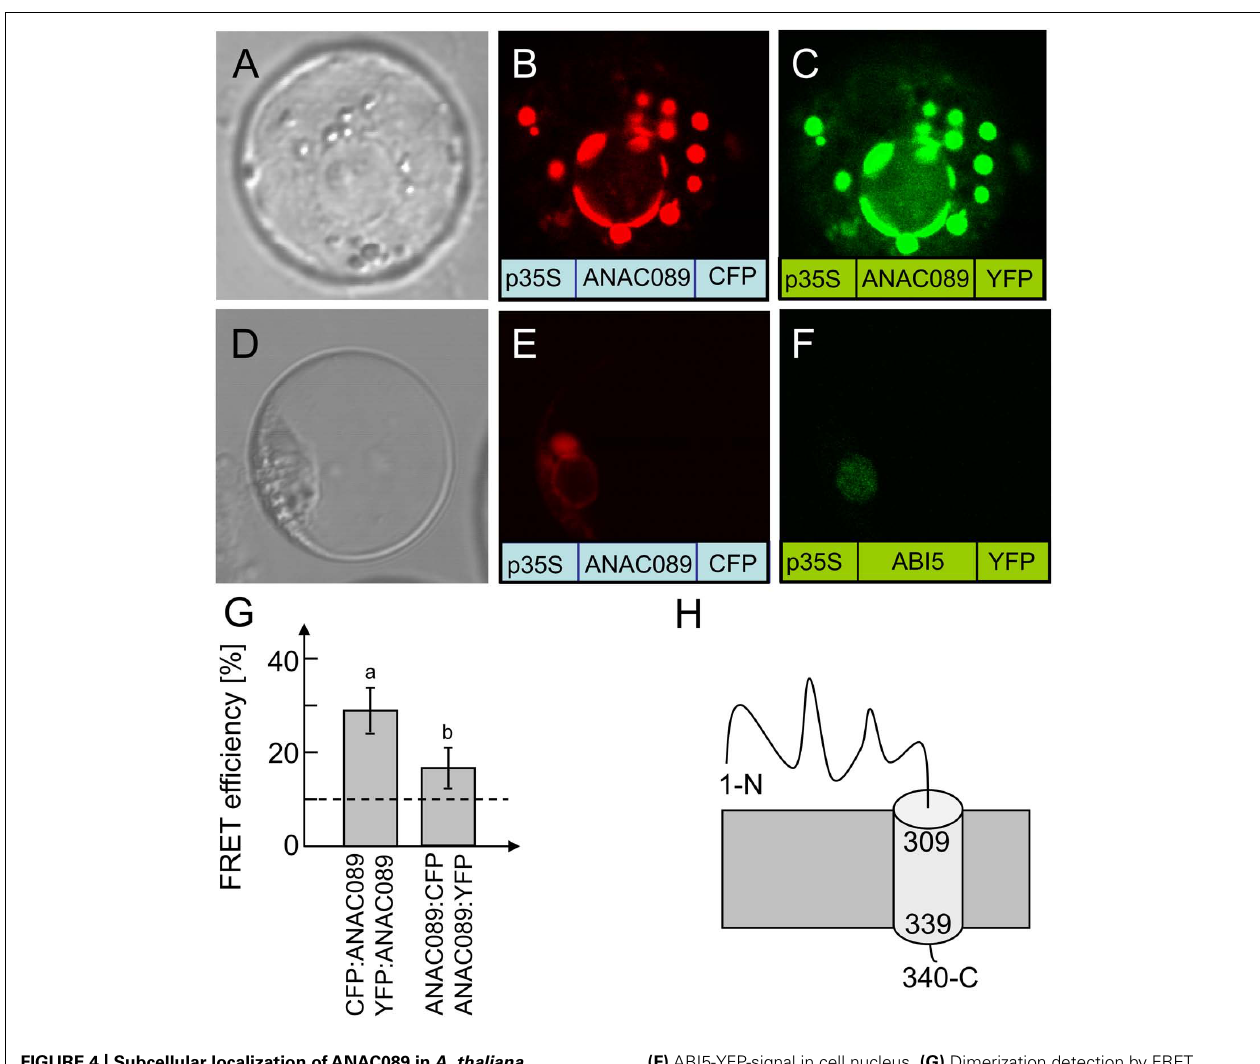
(F) ABI5-YFP-signal in cell nucleus. (G) Dimerization detection by FRET analysis: protoplasts were co-transfected with either CFP:ANAC089 and YFP:ANAC089:YFP (left column) or ANAC089:CFP and ANAC089:YFP (right). In both cases significant FRET above the threshold of co-expressed free CFP andYFP could be detected (mean ± SD, n > 60 protoplasts, three transfections). (H) Putative topology of ANAC089 in the